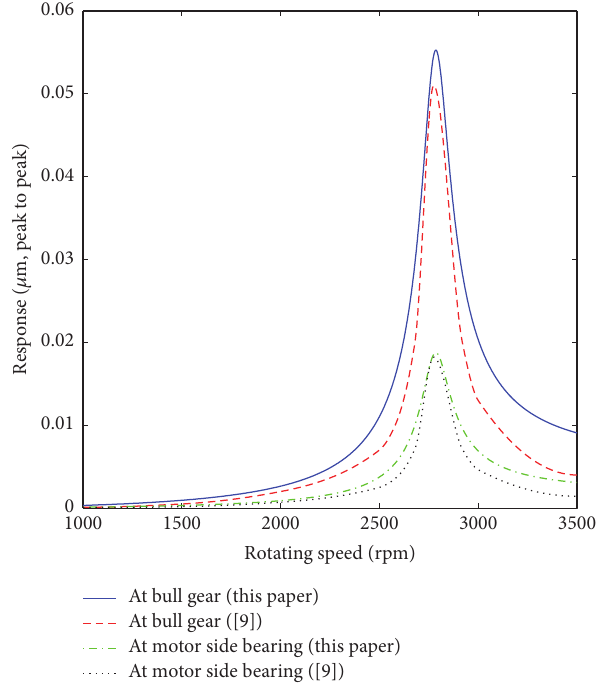
Figure 6: Unbalance responses comparing with [9].